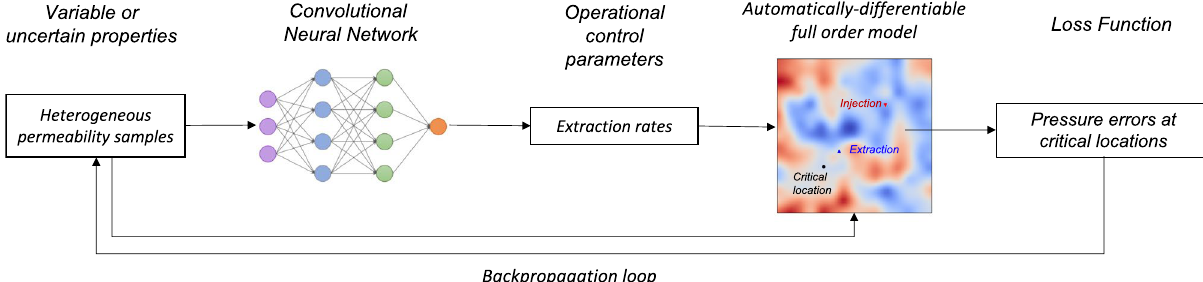
Figure 1. (Color online) Workflow diagram of physics-informed machine learning framework for managing reservoir pressures at a critical location during subsurface fluid injection. The key innovation of the surrogate model is the automatically-differentiable full-order model that allows for